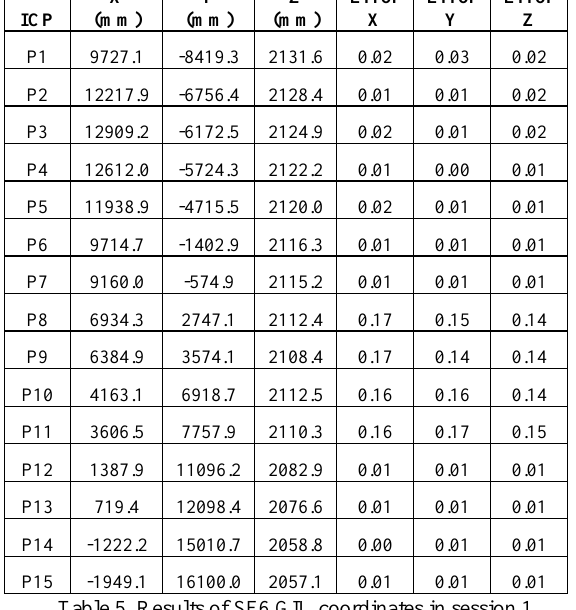
Table 7. The difference between the results of the measurement coordinates of session 1 and session